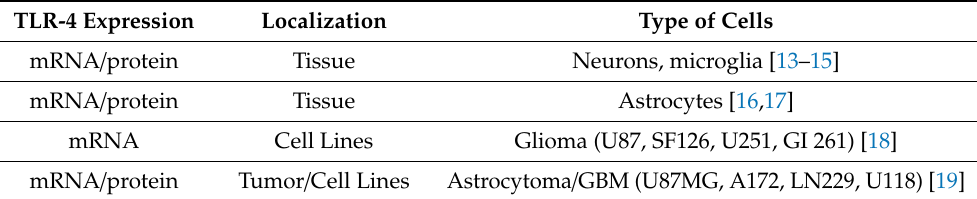
Table 1. Toll-like-receptor (TLR)-4 expression in brain tissue, cancer lines, and